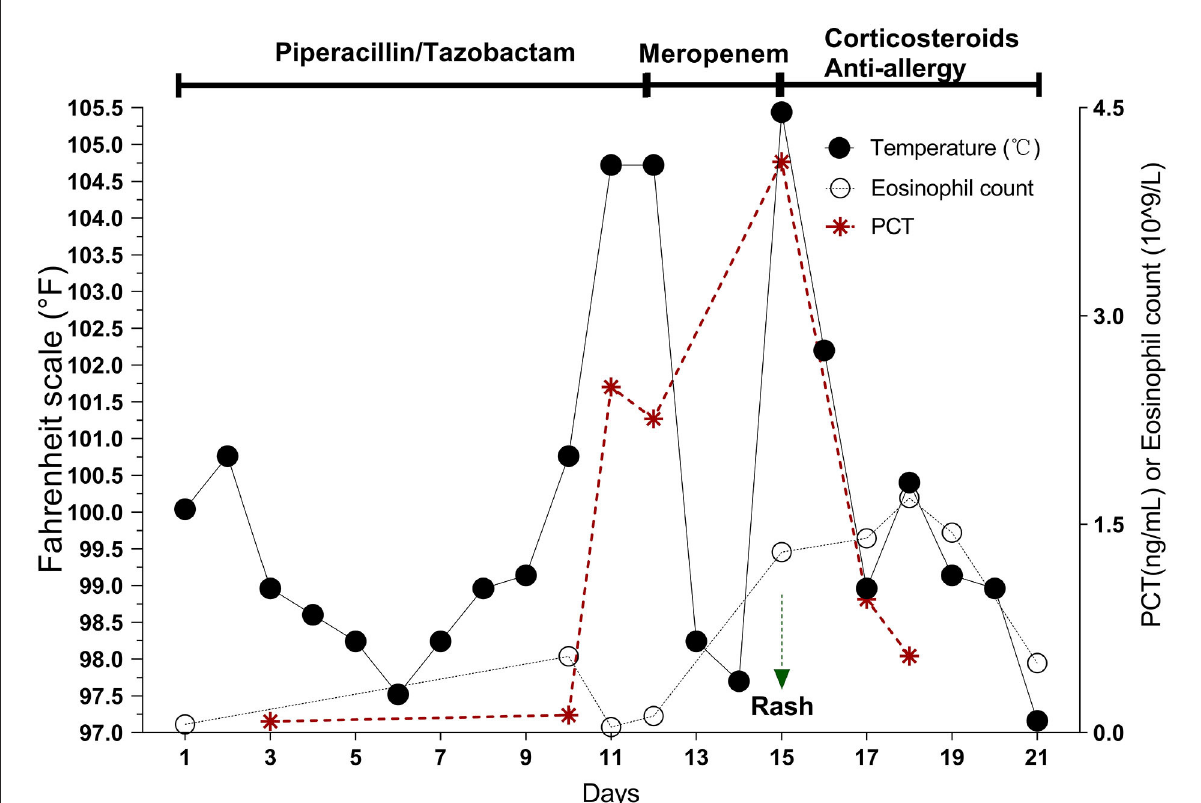
FIGURE2 On days 10–12 of Pip/taz, the patient develops hyperthermia with persistently elevated PCT but normal eosinophils. After discontinuing Pip/taz and administering meropenem for 72h (Day 15), the patient develops the characteristics of DRESS reaction (generalized rash, elevated eosinophils, hematologic abnormalities, and organ involvement), along with a markedly elevated PCT. After stopping the sensitizing drug and giving corticosteroids and anti-allergic drugs for about 1 week, the DRESS reaction subsides, and PCT decreases.